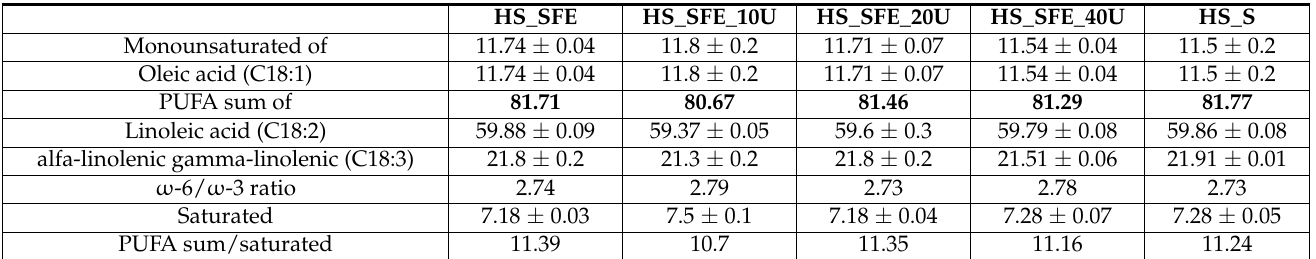
Table 3. Fatty acid composition of hempseed oil, cultivar Futura 75, extracted by supercritical CO 2 from untreated and ultrasound pre-treated hemp seeds and Soxhlet. Each data represents the mean value of three replicates ± standard